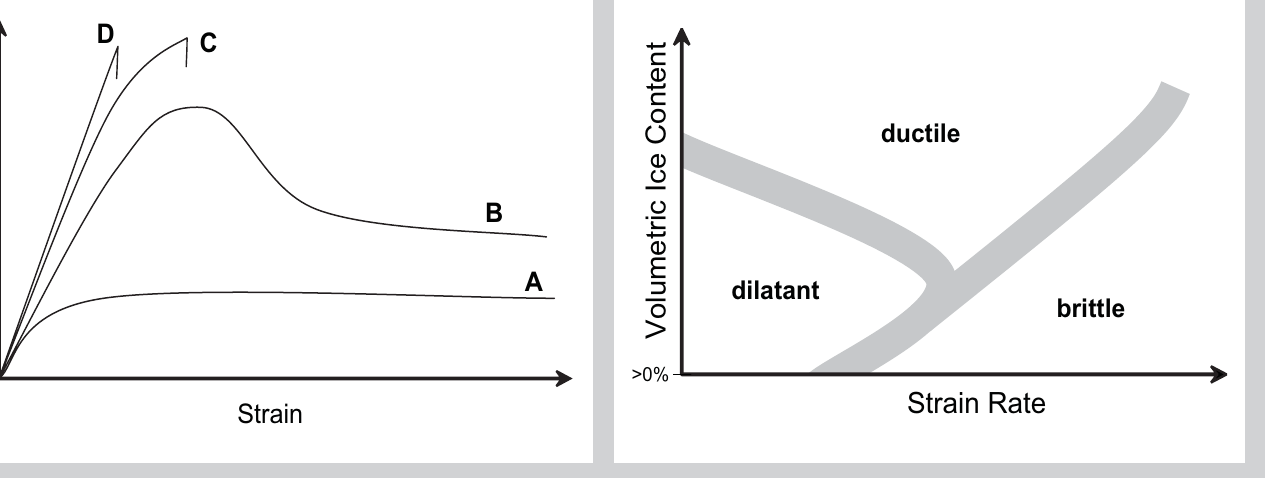
Figure 4 (below): Coarse grained (a: coarse sand) and frost susceptible fine grained (b: Devon silt) soil in an unfrozen (top) and a frozen (bottom) state. No change in the particle loca- tion is noted for the sand, whereas horizontal ice lens- es (black) start to form in the silty sample (NB: The sand freezes from the bot- tom upwards and the silt from the top down). Figure 5 (left above): Stress-strain behaviour for ice subjected to a constant strain rate (after [64]). A) ductile behaviour with strain hardening; B) dilatant behaviour with strain soft- ening; C) brittle behaviour with failure just after yield point; D: brittle failure. Figure 6 (right above): Stress response as a function of the strain rate and the ice content (after